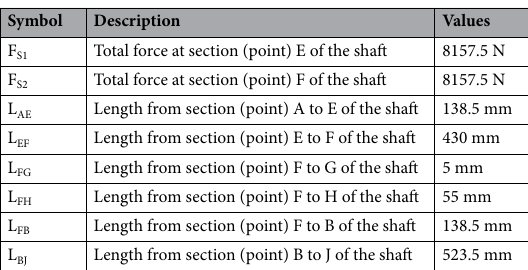
Table 3. Parameters for bending moment analysis.